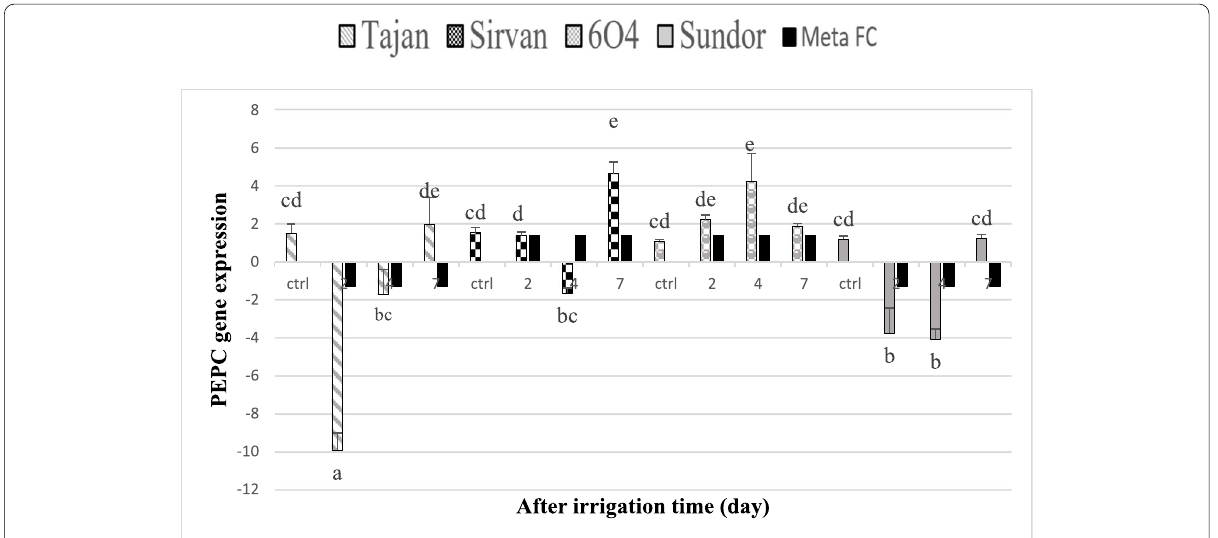
Fig. 8 Expression level of PEPC gene in tolerant wheat (6O4 and Sirvan) and sensitive wheat (Sundor and Tajan) genotypes at three stress levels 2, 4, and 7 days after drought stress. FC column based on the results of meta-analysis performed for susceptible and resistant cultivars placed separately next to each expression level columns for better comparison of the results